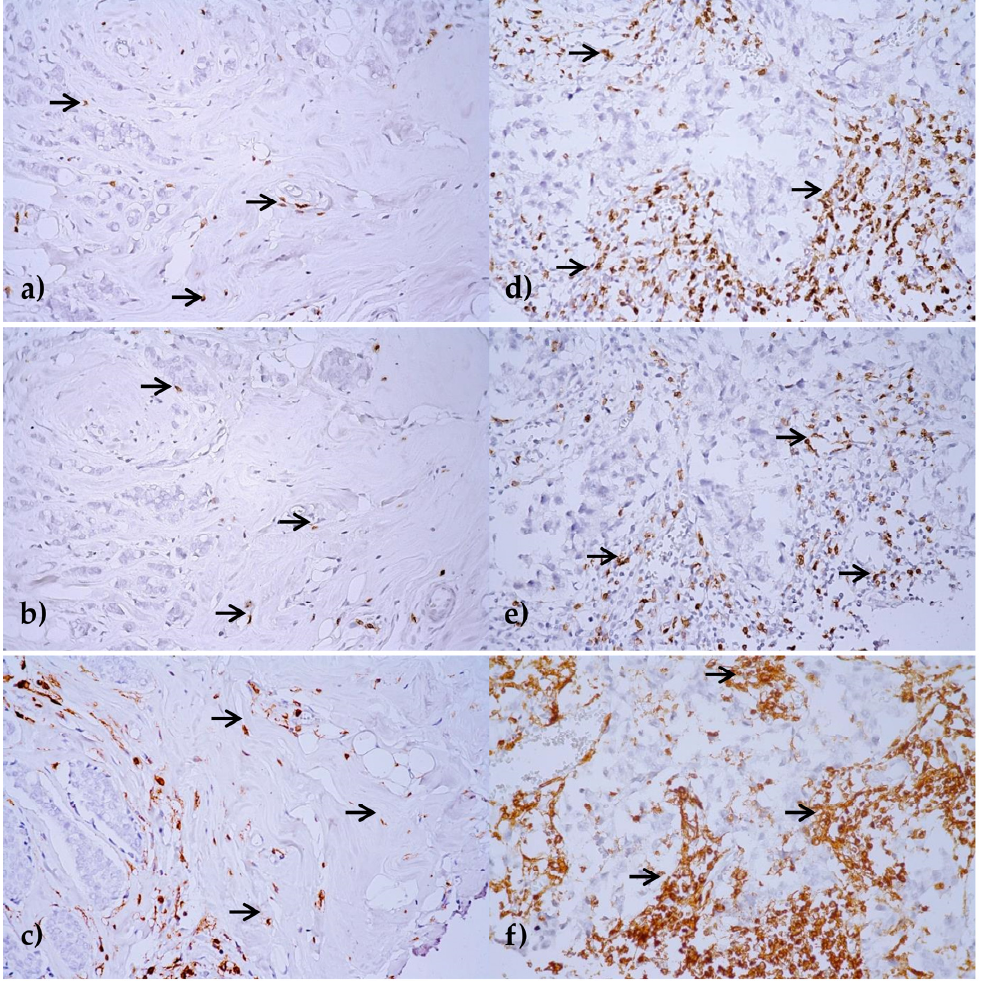
Figure 1. Immunohistochemical expression of CD3 ( a , d ), CD8 ( b , e ) and CD45RO ( c , f ) in stromal tumor-infiltratinglymphocytes(TILs). Breastcancertissueareaswithlow( a – c ),andhighstromalTIL( d – f ) infiltrationaremarkedbyarrows. Originalmagnification × 400,visualizationwith3,3 (cid:48)